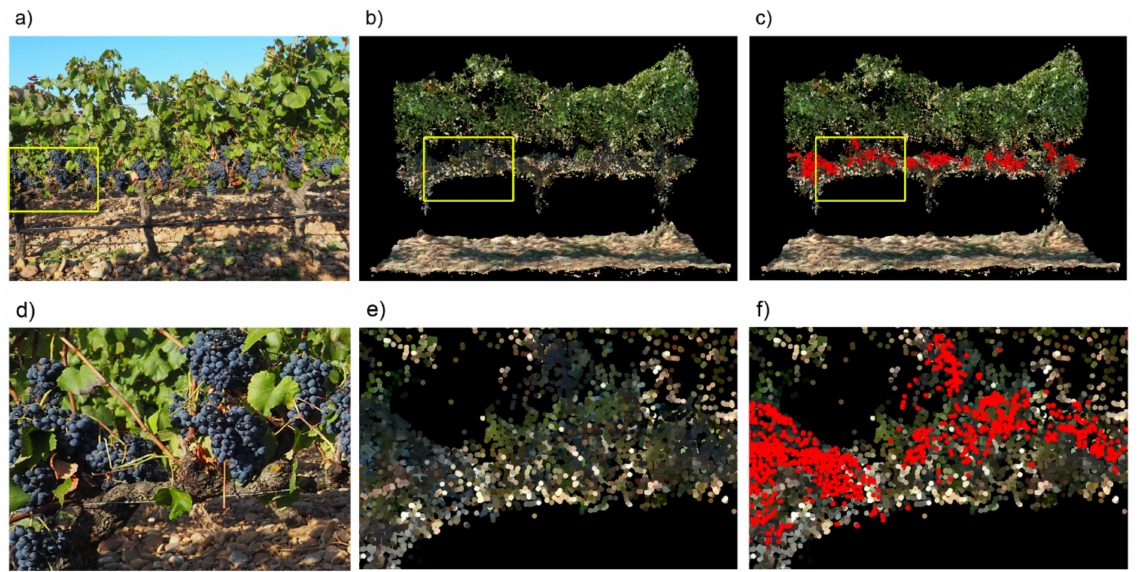
Figure 5. Example of the cluster detection in a vine row segment of Garnacha field with two sides leaf removal: ( a ) image of the vines in field; ( b ) segment of the point cloud showing the same vines; ( c ) same than ( b ) with cluster detected points highlighted in red color; ( d ), ( e ), and ( f ) are close ups of the areas marked by a yellow rectangle in ( a ), ( b ), and ( c ),